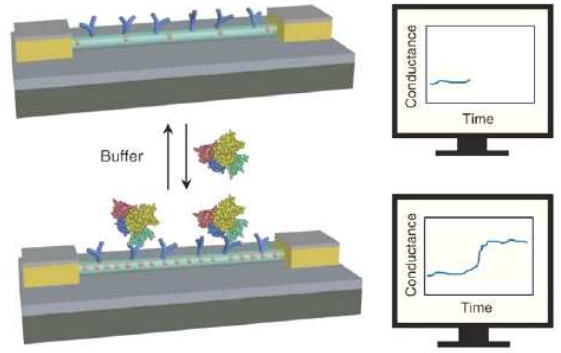
Figure 6. Schematic of the silicon nanowire sensor for label-free and real-time protein detection. From Patolsky et al ., MRS Bulletin 2007 , 32 , 142-148. Reprinted with permission from